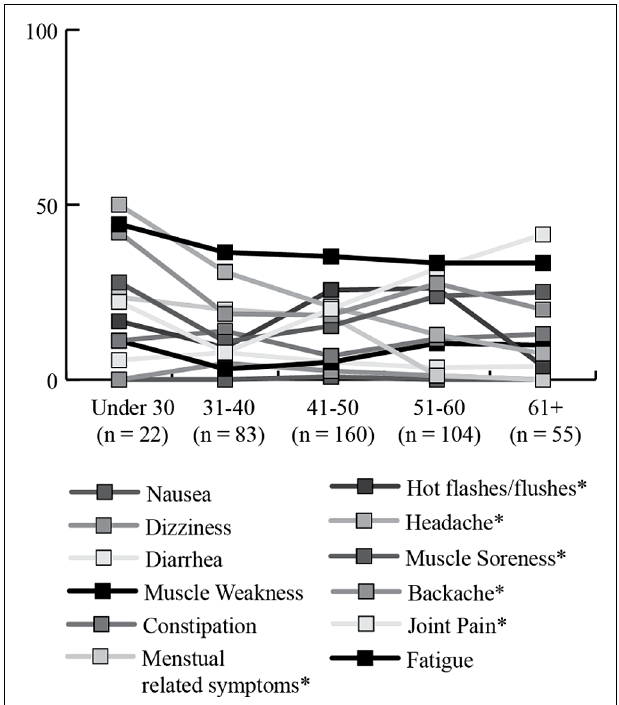
FIGURE 6 | Percentage of women endorsing having experienced specific physical health symptoms “often or very often”in the previous 30 days, by age group. *Significant differences across age groups.